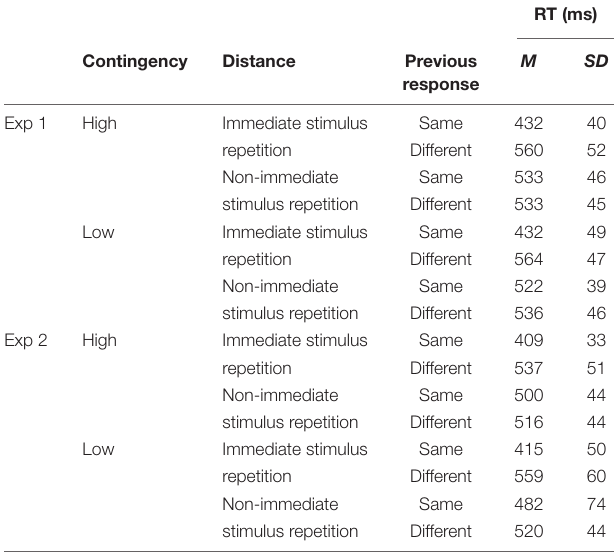
TABLE 3 | Average RTs (and SDs) for the combinations of contingency (high vs. low), previous response (same vs. different), and distance (immediate vs. non immediate stimulus repetition) in Experiments 1 and